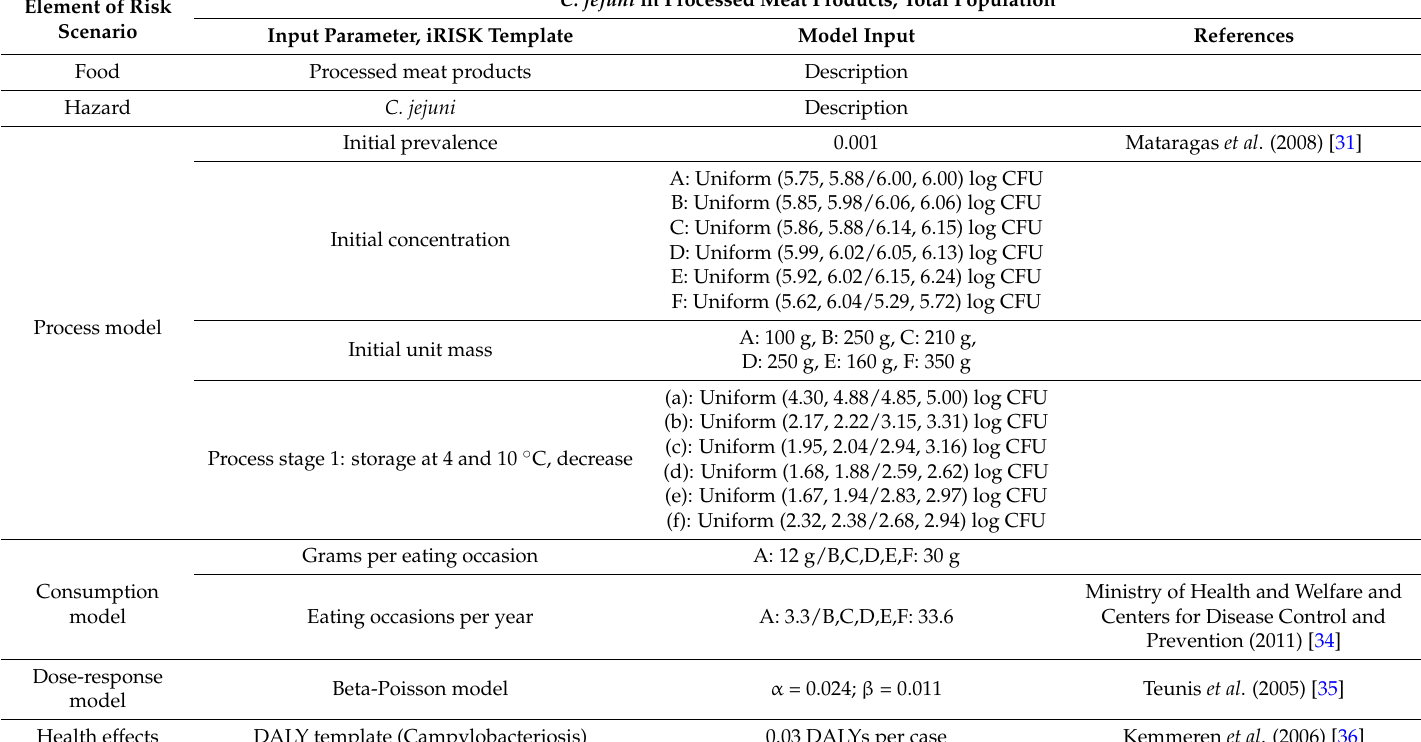
Table 1. Model inputs for food-hazard scenarios in FDA-iRISK